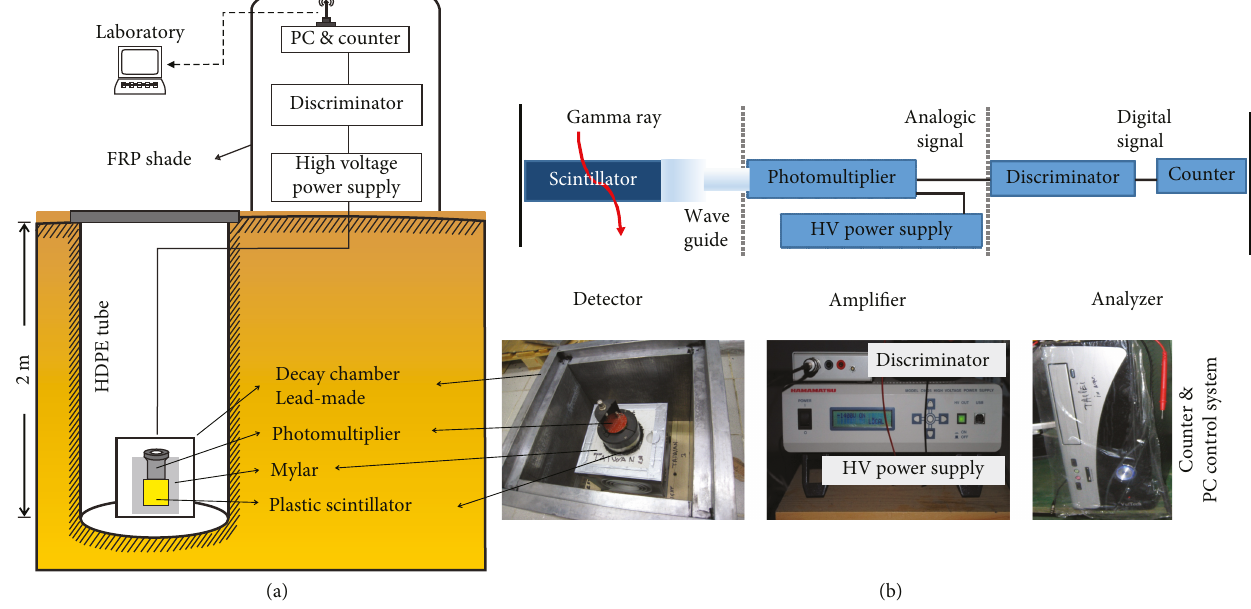
Figure 2: (a) Schematic of the gamma ray sensor installation in the YMSG monitoring station. (b) The block diagram and pictures of the gamma sensor